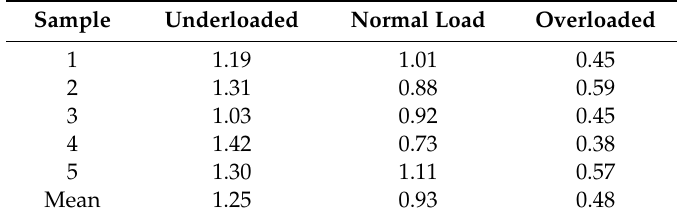
Table 2. Fuzzy entropy values of three types of load state vibration